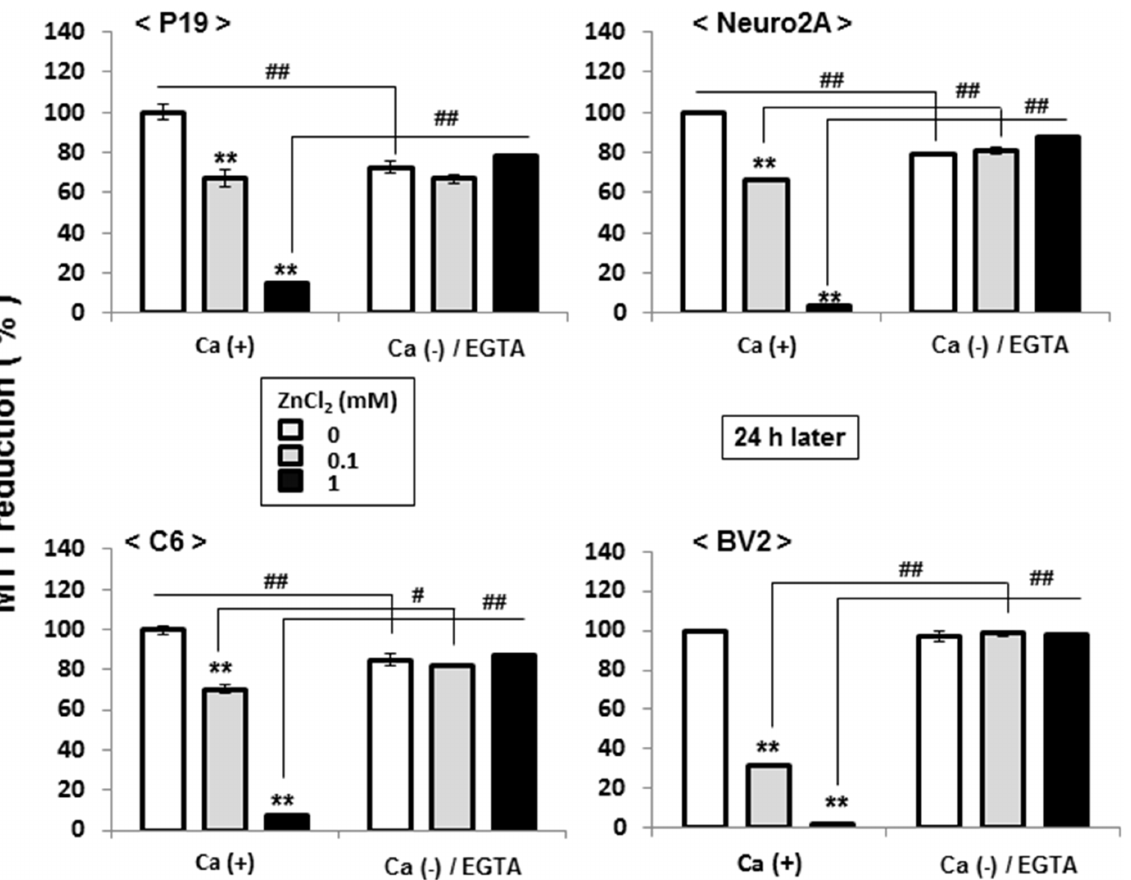
Fig 16. Effects of ZnCl 2 on MTT reducing activity in different cell lines. Cells were exposed to ZnCl 2 at 0.1 or 1 mM in either the presence or absence of CaCl 2 and EGTA for 1 h, followed by culture for an additional 24 h and subsequent determination of MTT reducing activity. Values are the mean ± S.E. of percentages over the maximal activity detected in cells not exposed to any test chemicals in 3 different experiments. * P < 0.05, ** P < 0.01, significantly different from the control value in cells not exposed to ZnCl 2 . # P < 0.05, # P < 0.01, significantly different from the value in cells exposed to ZnCL 2 at each concentration.